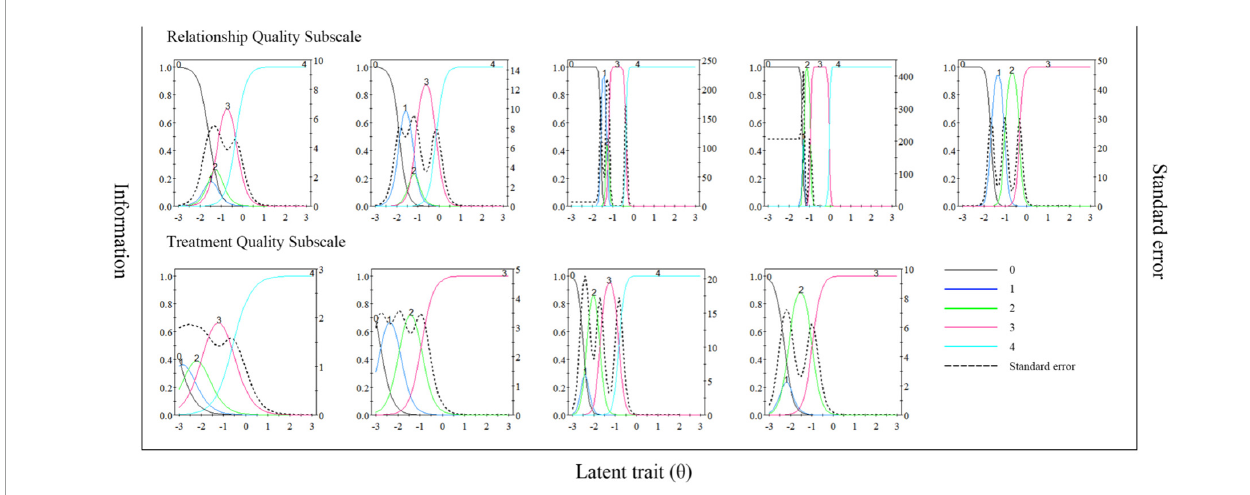
FIGURE2 Item characteristic curves and item information curves of items in the PDRQ-9.